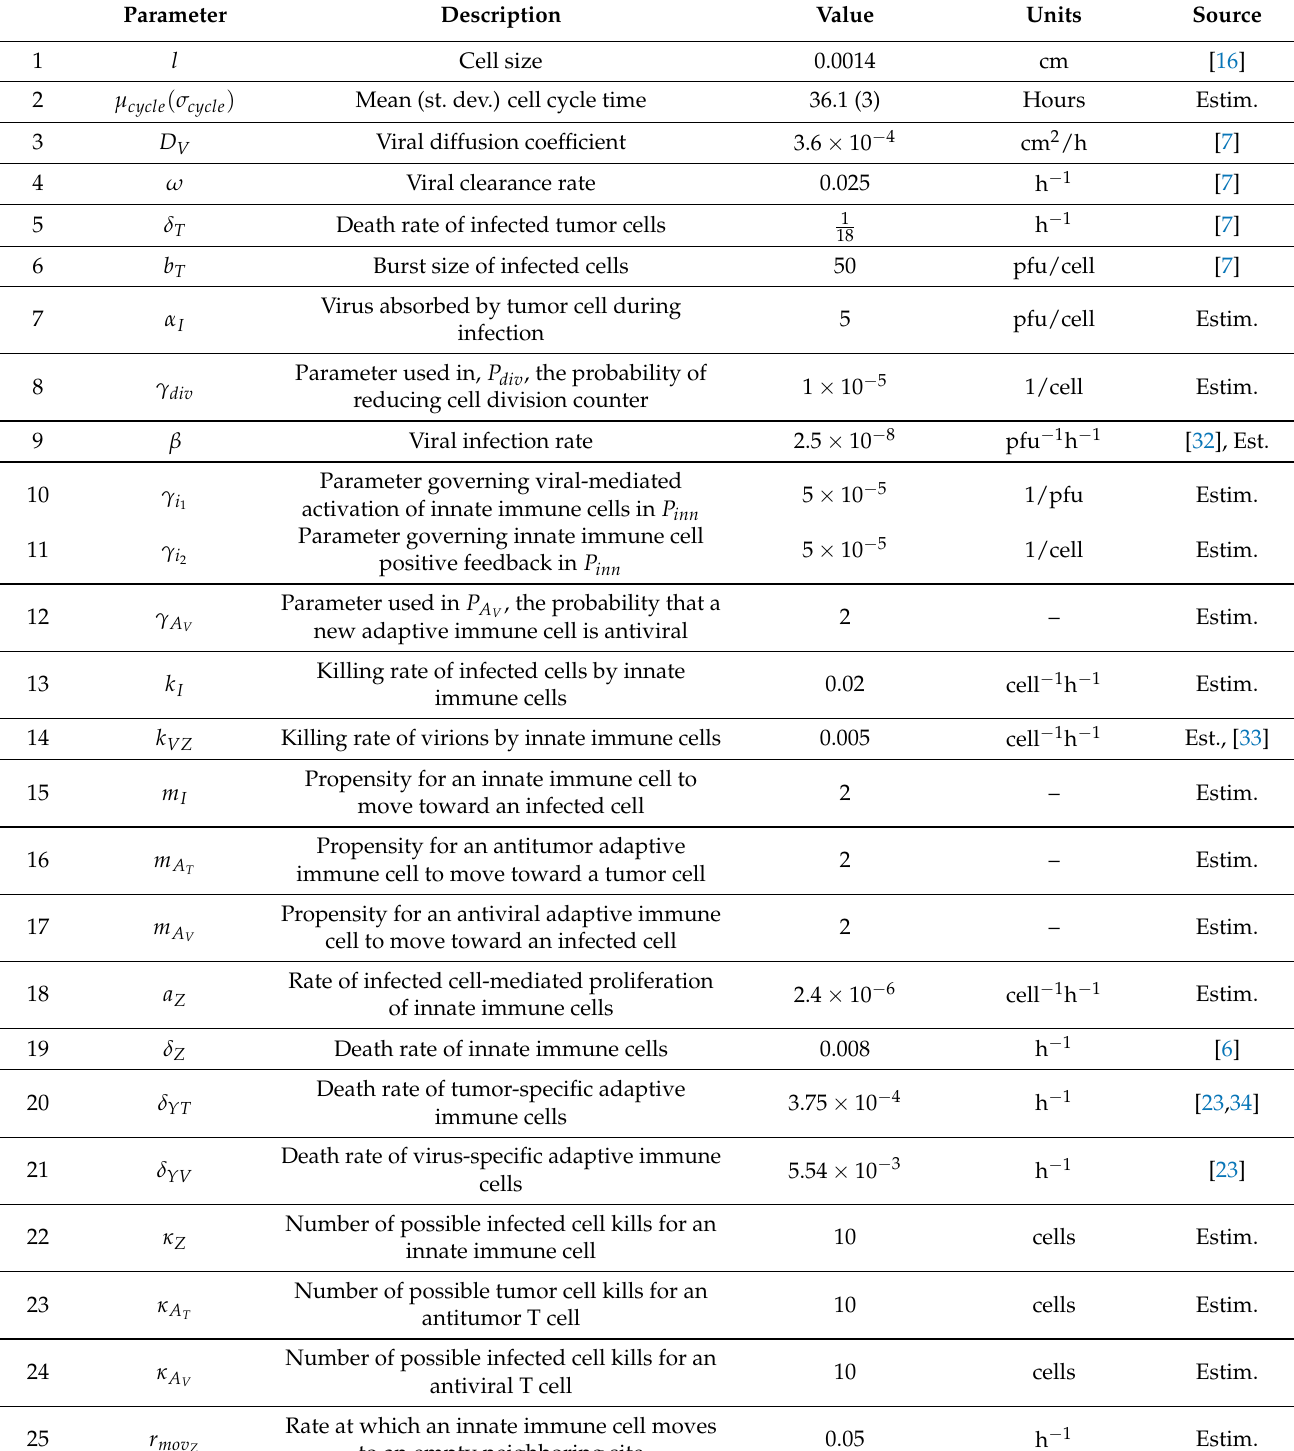
Table A1. Baseline parameters in